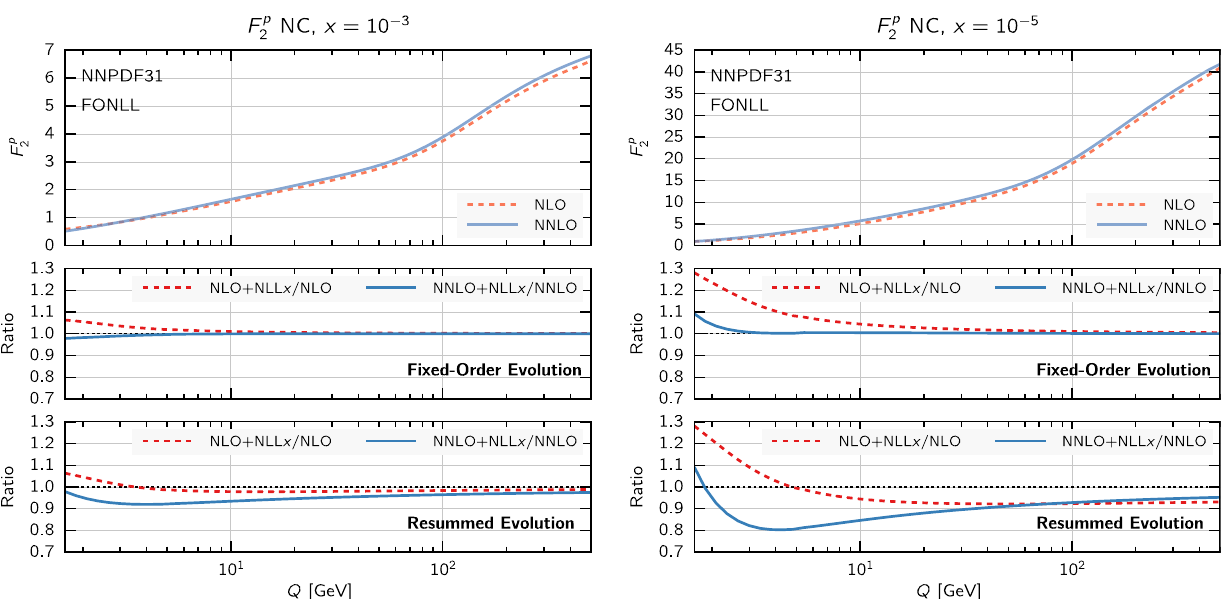
Fig. 3 The proton neutral-current (NC) structure function F 2 ( x , Q ) as a function of Q for two different values of x (left: x = 10 − 3 ; right: x = 10 − 5 ) and using different calculational schemes. In the top panels we show the structure function computed in fixed-order perturbation theory (NLO and NNLO). In the middle and bottom panels we show the ratio of resummed results (NLO+NLL x and NNLO+NLL x ) to their fixed-order counterparts. In particular, in the middle panel the resum-